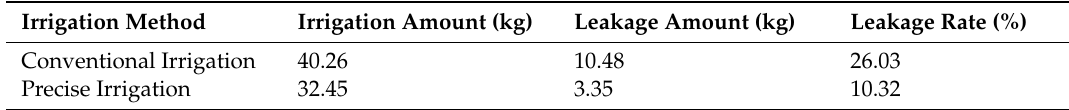
Table 5. Total irrigation, leakage, and leakage